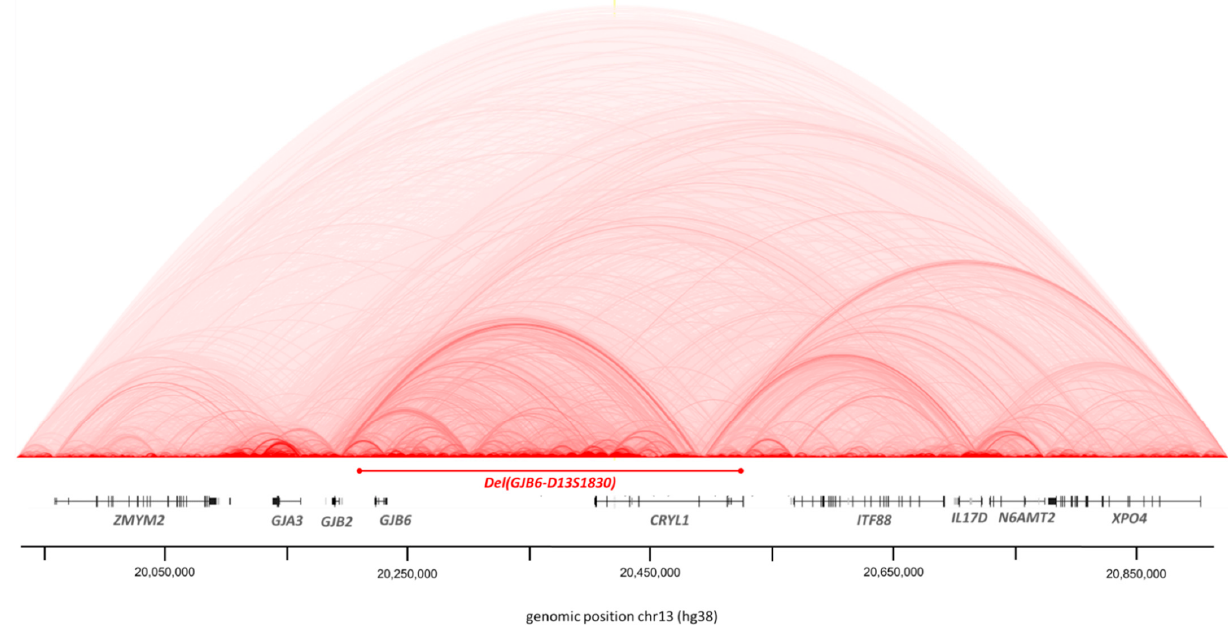
Figure 9. Deletion del(GJB6-D13S1830) of patient P5. Deletion del(GJB6-D13S1830) disrupted GJB6 gene and CRYL1 gene but GJB2 remained intact. Table 3. USH1C variants of patient P5. Three variants detected via WGS